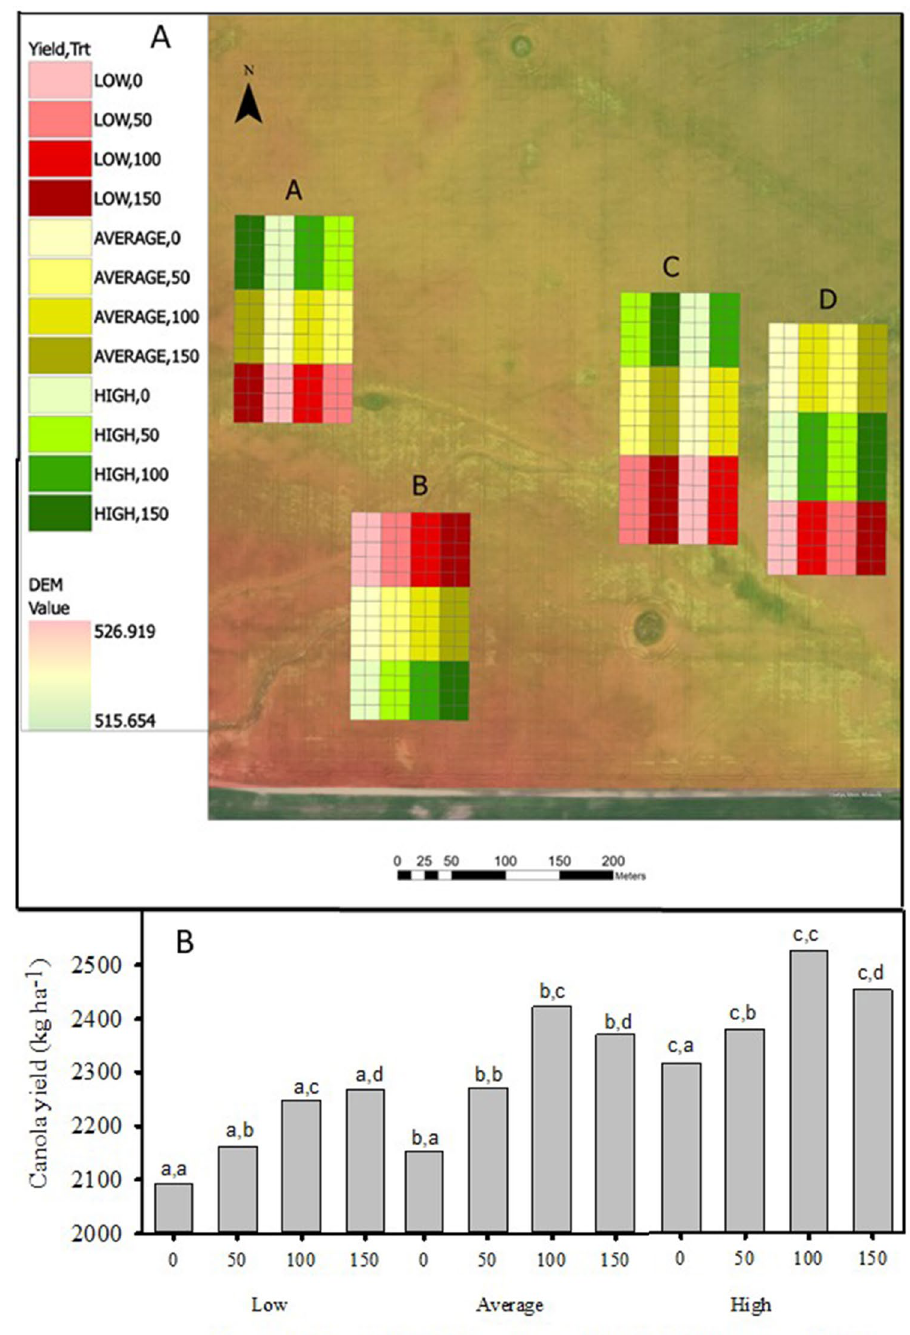
Figure 1. ( A ) Experimental design of yield zones and fertilizer treatments projected over a Digital Elevation Model (m). ( B ) Response of canola seed production to nitrogen fertilizer treatments in three yield zones for analysis of 27 sites in Alberta, Saskatchewan and Manitoba from 2014 to 2017. Multiple pairwise comparisons (Tukey HSD), first letter between fertilizer treatments within zone, second letter for controls between zones [( A ) ESRI ArcMAP version 10.41, Esri.com. ( B ) SigmaPlot, vision 14, https ://systa tsoft